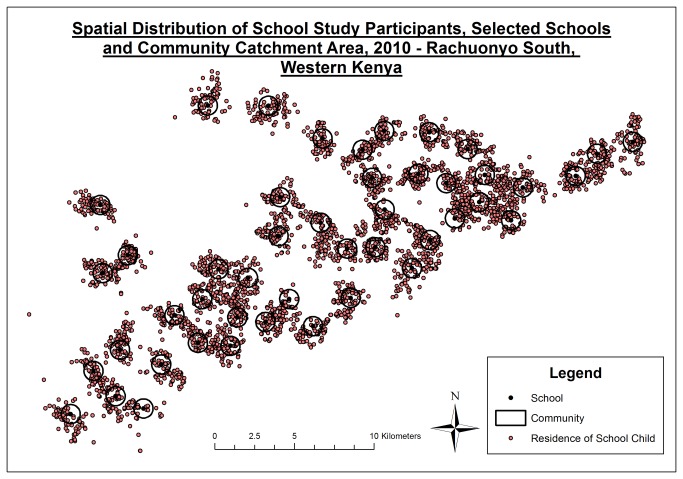
Spatial distribution of school study participants, location of the schools, and community catchment area.Each point represents the compound of a child included in the study. The black crosses indicate the location of each school that was included in the survey. The black circular outline corresponds to the area with a 600m radius around each school and thus represents the community catchment area sampled during the community survey.